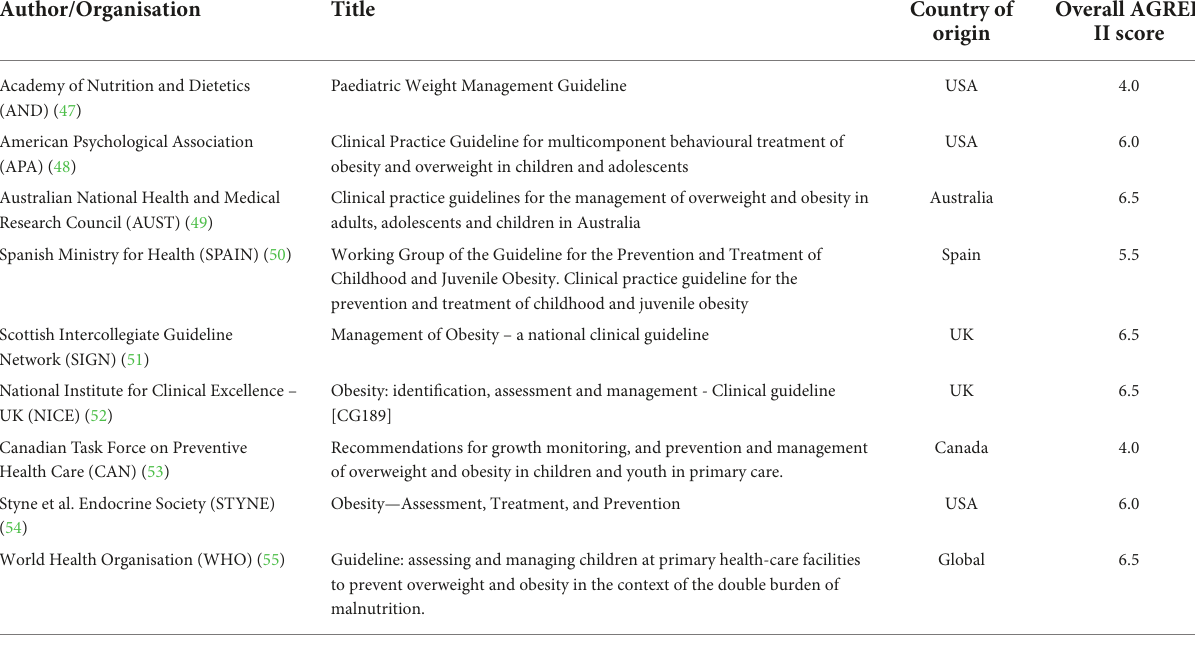
TABLE 1 Clinical practice guidelines deemed to be high quality and included in the review.